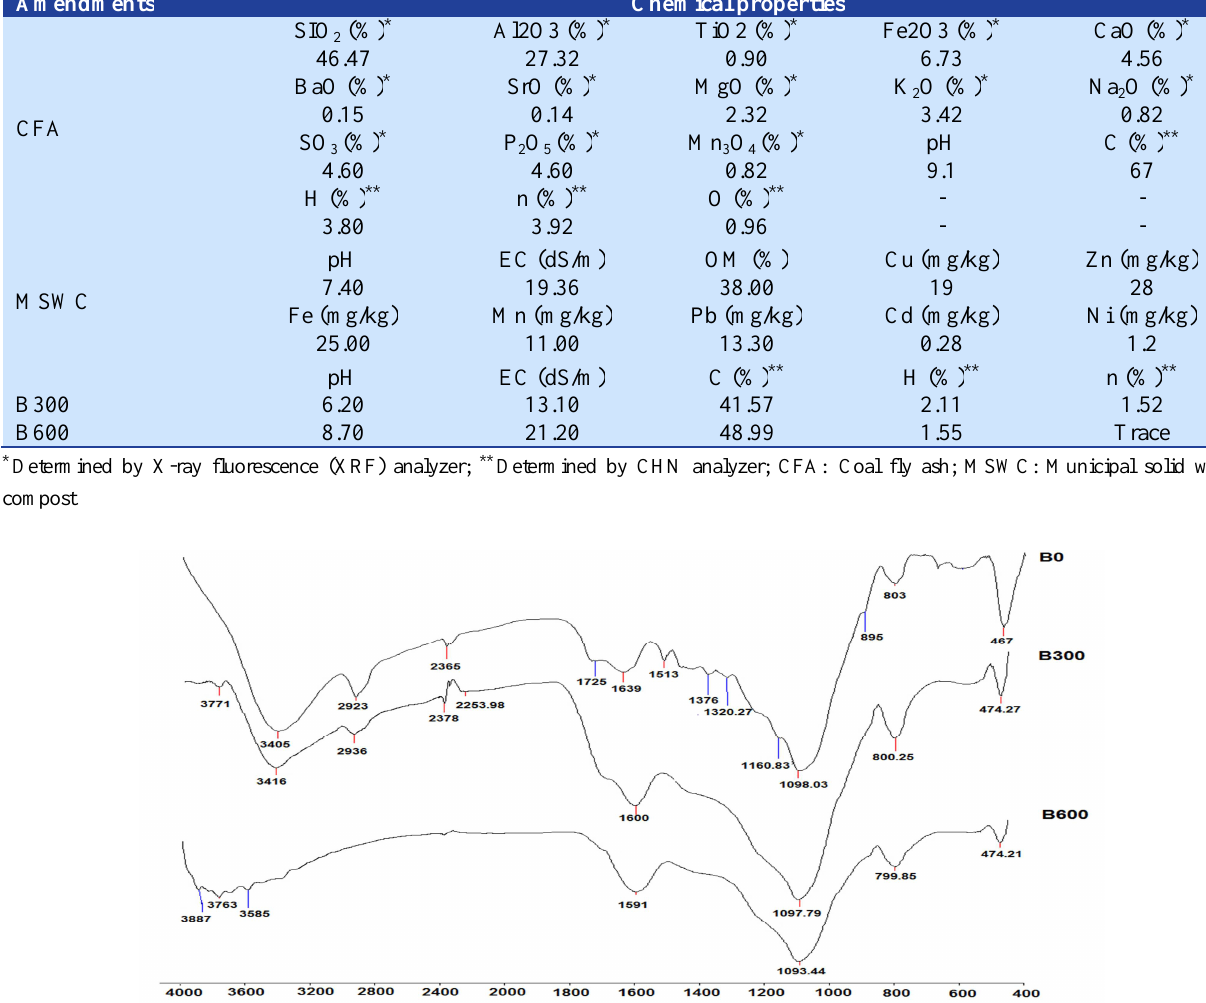
Table 2. Selected chemical composition of amendments Amendments